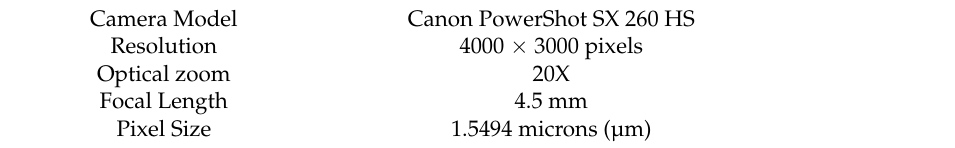
Table 3. Specifications of the digital